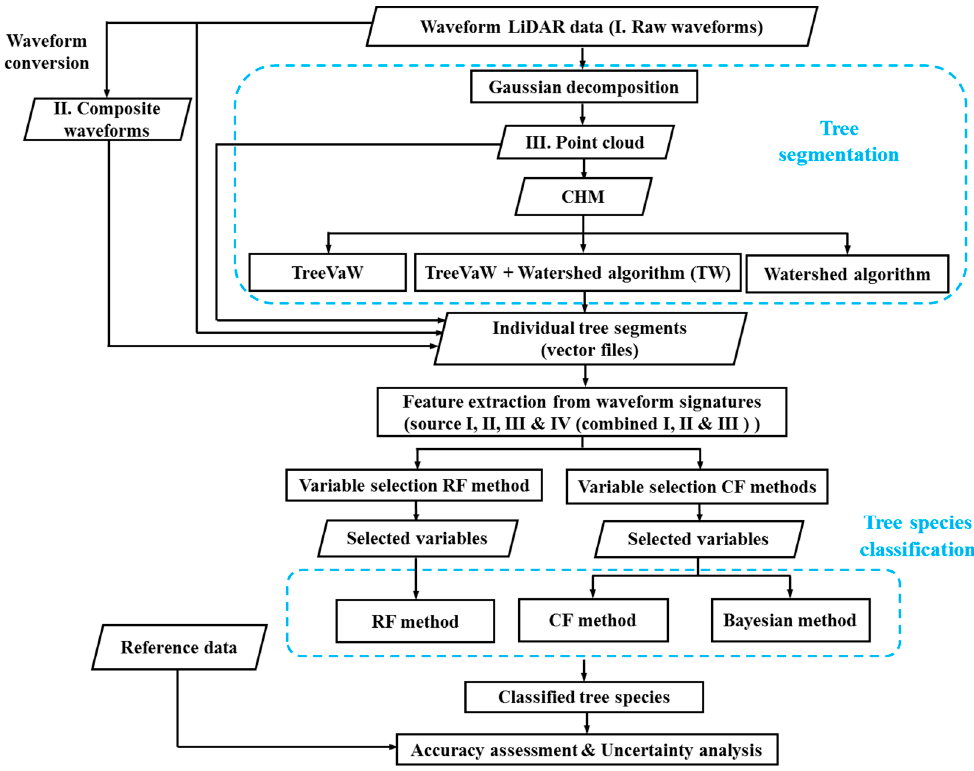
Figure 2. Flowchart for the tree species classification using waveform LiDAR data. CHM: Canopy Height Model. RF: Random forests. CF: Conditional inference forests.